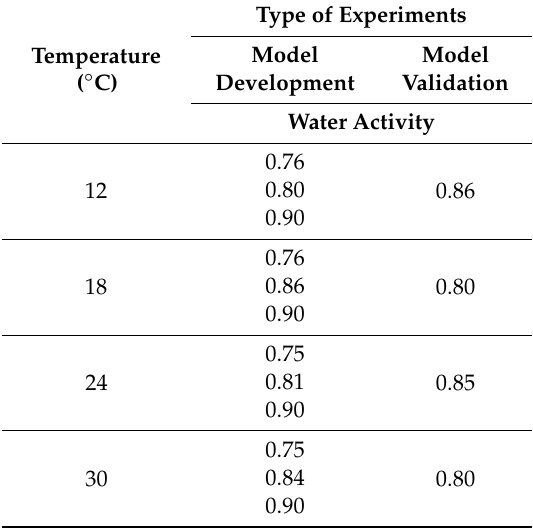
Table 1. Storage conditions under which the experimental data describing the mold growth in rapeseed ecosystems were